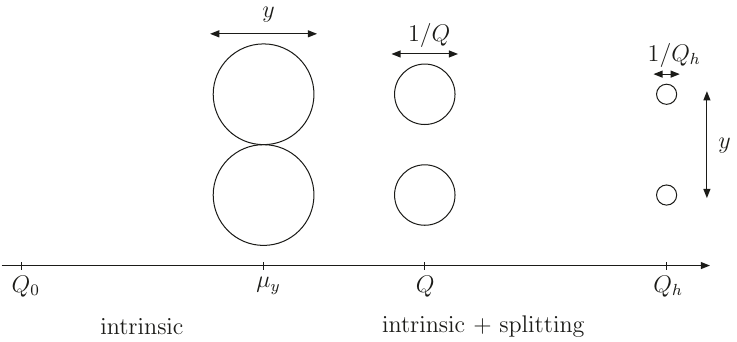
Figure 4 . Sketch of the backward evolution of a DPS. The axis shows the evolution scale. At the starting scale Q h , the two partons belonging to the same proton have a size 1 =Q h . This size increases during the backward evolution. At the scale (cid:22) y , the two partons have a size y which is equal to the distance which separates them and they may be resolved into a single parton. The components of the dPDFs which are used are